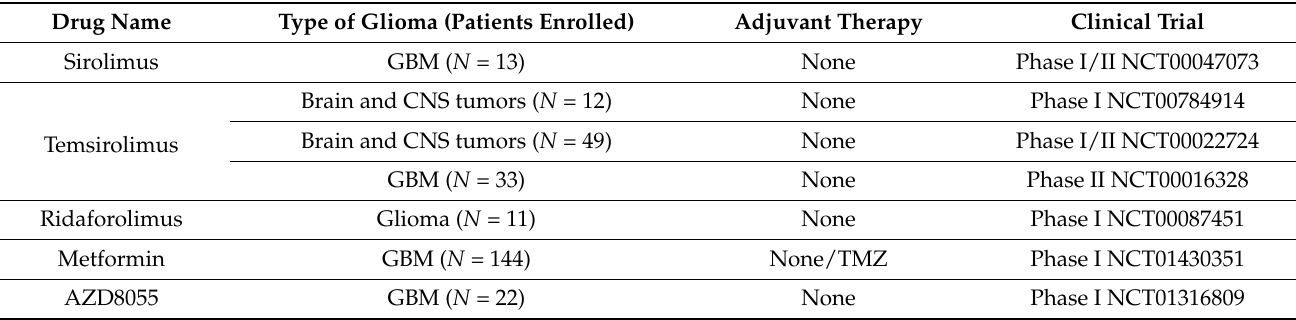
Table 2. Ongoing clinical trials on adult gliomas targeting mTOR kinase (data from http://clinicaltrials.gov, accessed on 30 April 2021).